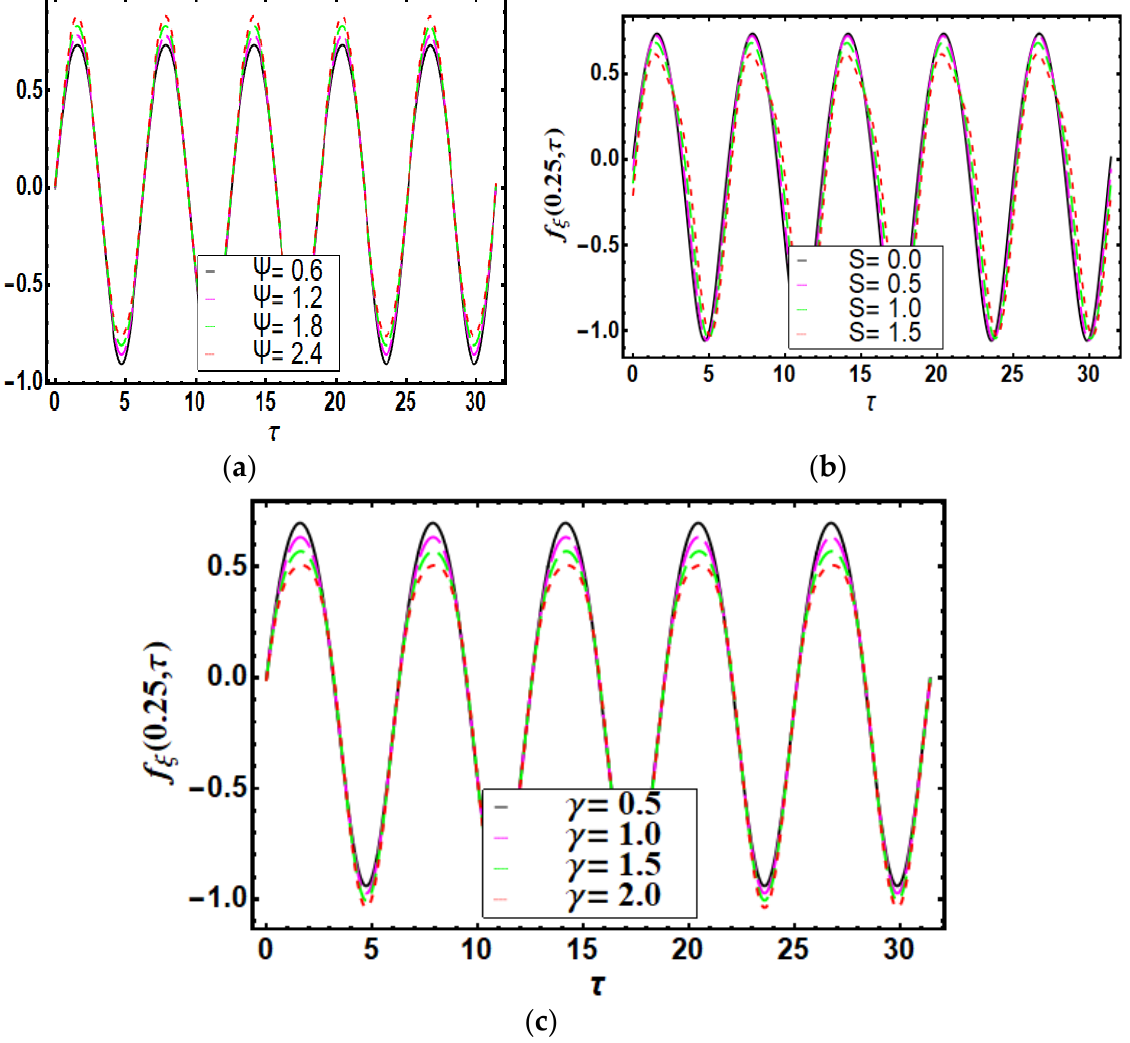
γ Ψ f f Figure 4. ( a ) Effects of Ψ on f ξ . ( b ) Effects of S on f ξ . ( c ) Effects of γ on f ξ . S on f Figure 4. ( a ) E ff ects of on on ξ . ( b ) E ff ects of ξ . ( c ) E ff ects of ξ . Figure 5a is plotted to analyze the effect of Ψ on the velocity profile g ξ . An increase in the oscillation amplitude of the velocity is encountered when Ψ is increased. Figure 5b depicts the variation in the velocity g ξ for different values of S . A reducing nature of the velocity is observed when larger S values are imposed. Such observations are associated to the oscillating frequency. Figure 5c is drawn to describe the behavior of g ξ for various values of γ . A declining trend of the velocity amplitude is noticed when γ is increased. Such declining behavior is due to the permeability of porous